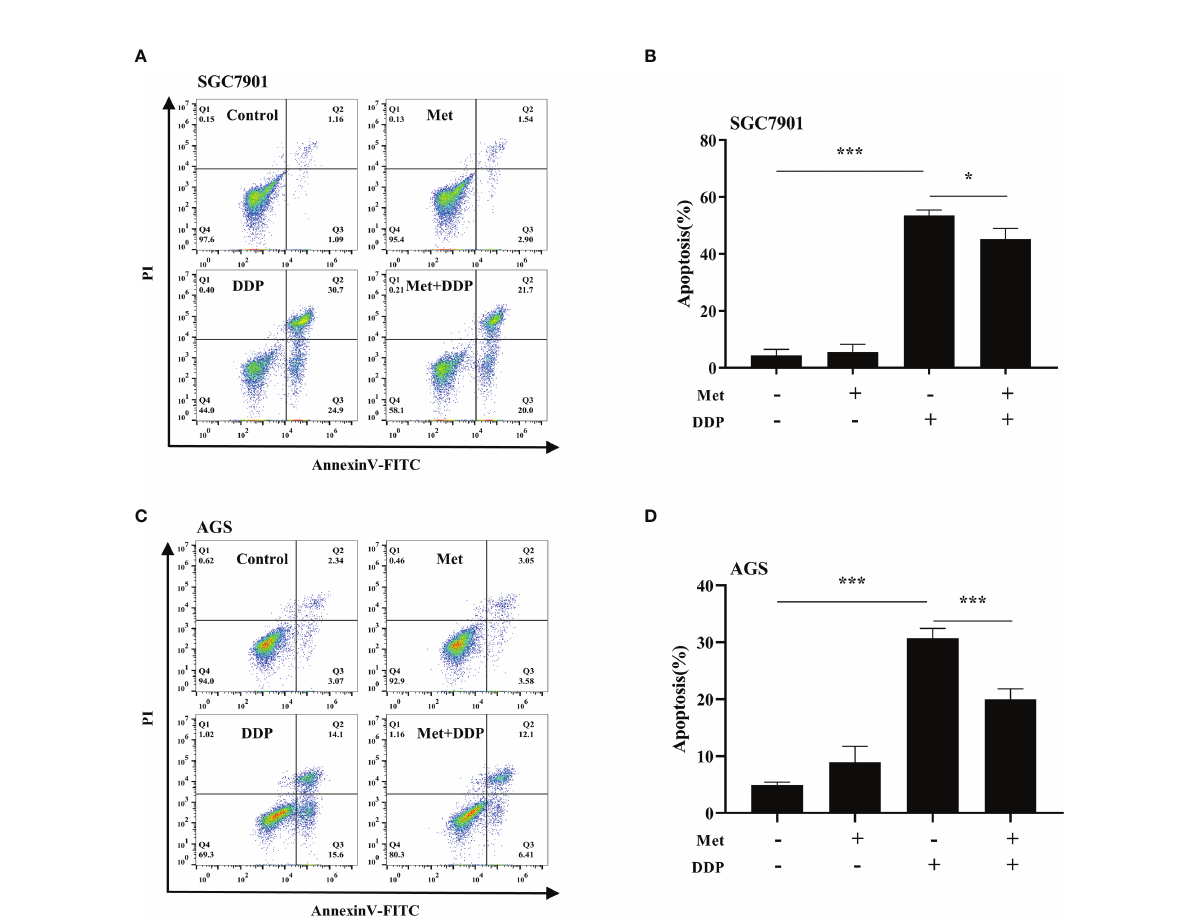
FIGURE 3 Metformin alleviates cisplatin-induced apoptosis in GC cells. (A, B) SGC-7901 cells were treated with metformin (10 mM), DDP (5 m g/mL), or the combination of metformin (10 mM) and DDP (5 m g/mL) for 24 h. (C, D) AGS cells were incubated with metformin (10 mM), DDP (10 m g/mL), or combination of metformin (10 mM) and DDP (10 m g/mL) for 24 h. Cell apoptosis was analyzed by Annexin V/PI staining. Bar diagram represents percentage of apoptotic cells. Data were presented as the means ± SD. The experiments were repeated three times. * p <0.05, *** p